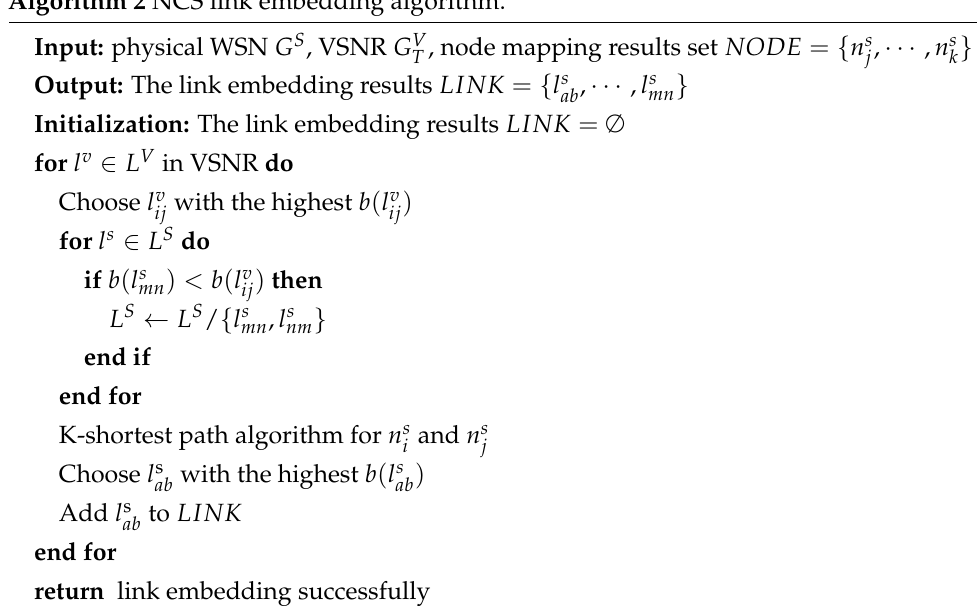
Algorithm 2 NCS link embedding